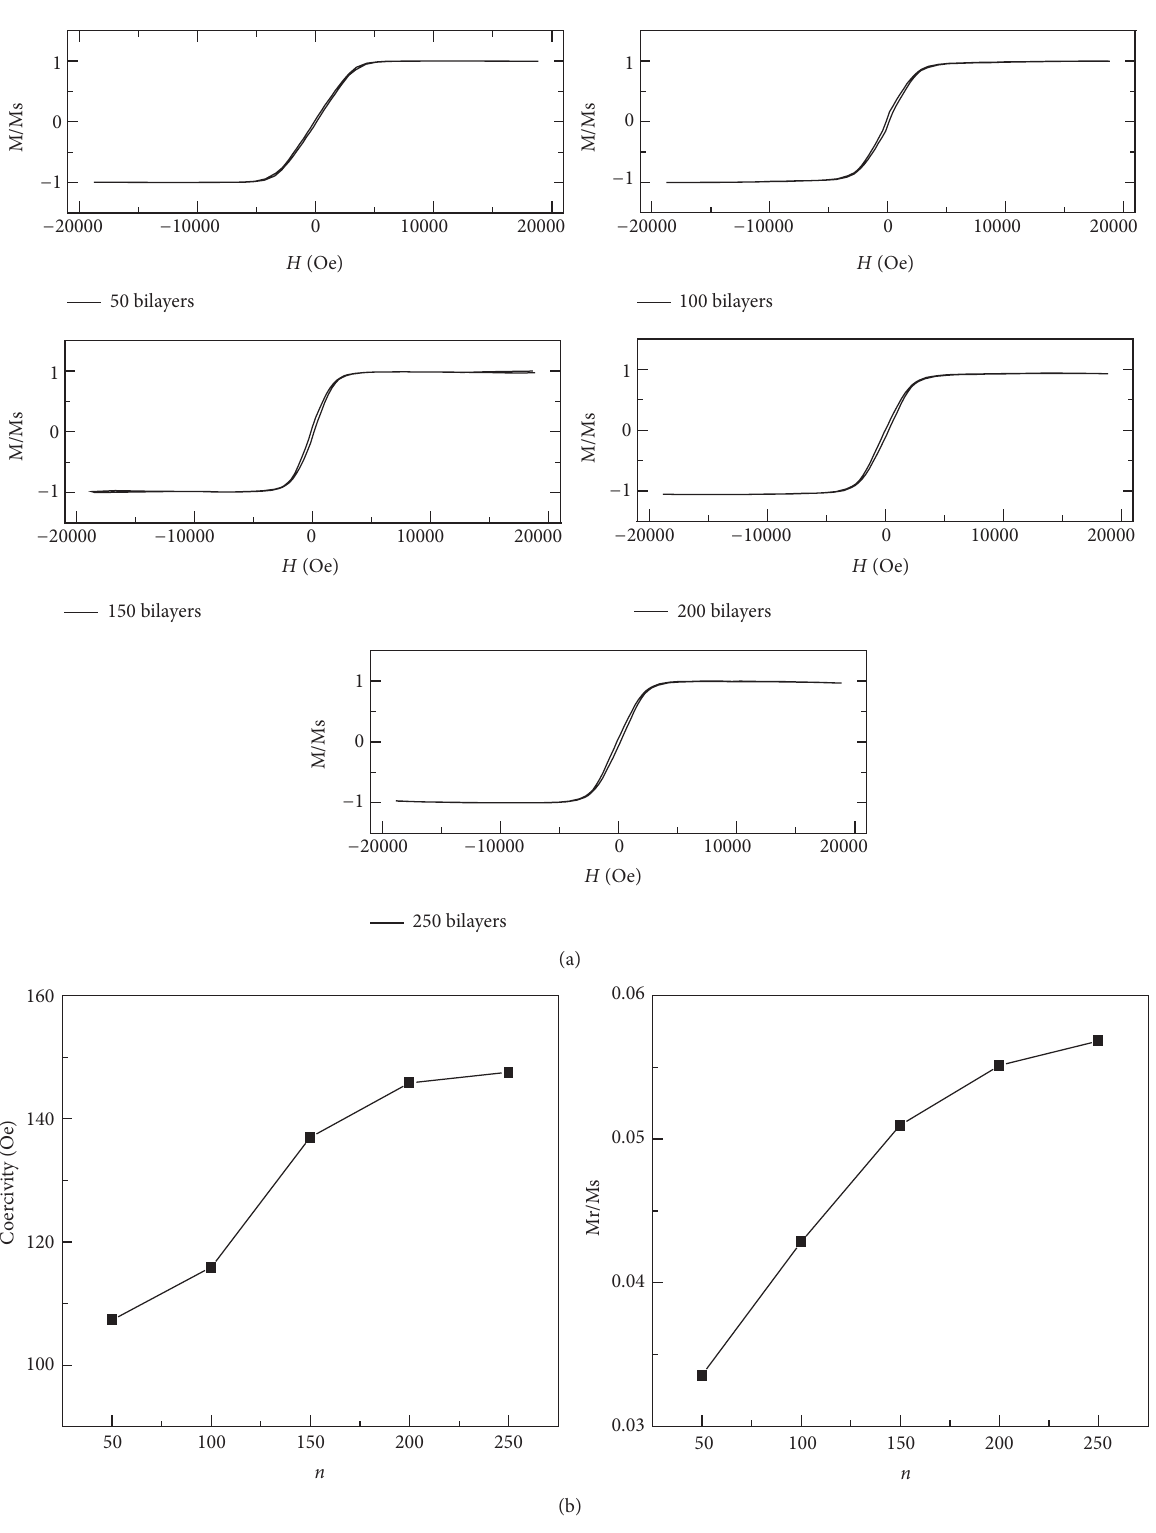
Figure 6: Magnetic hysteresis loops of Co/Cu nanowires with Co (50nm)/Cu (5nm) of different period numbers and the evolution of the coercivity ( 𝐻 c ) and remanence ratio (Mr/Ms) with the change of period number under the applied magnetic field parallel to the